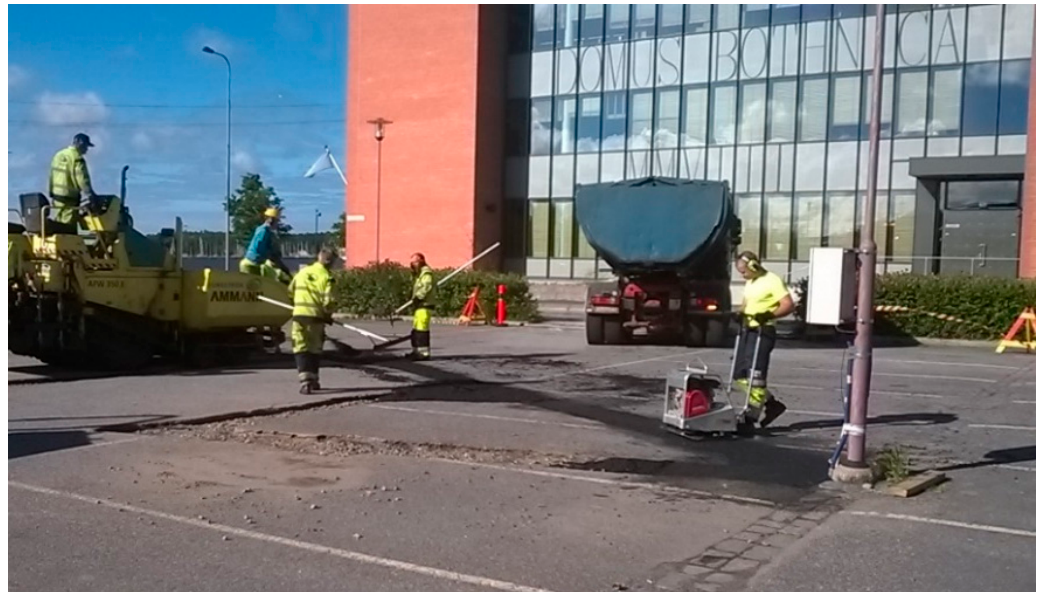
Figure 2. The measurement field receives asphalt pavement after drilling and digging.